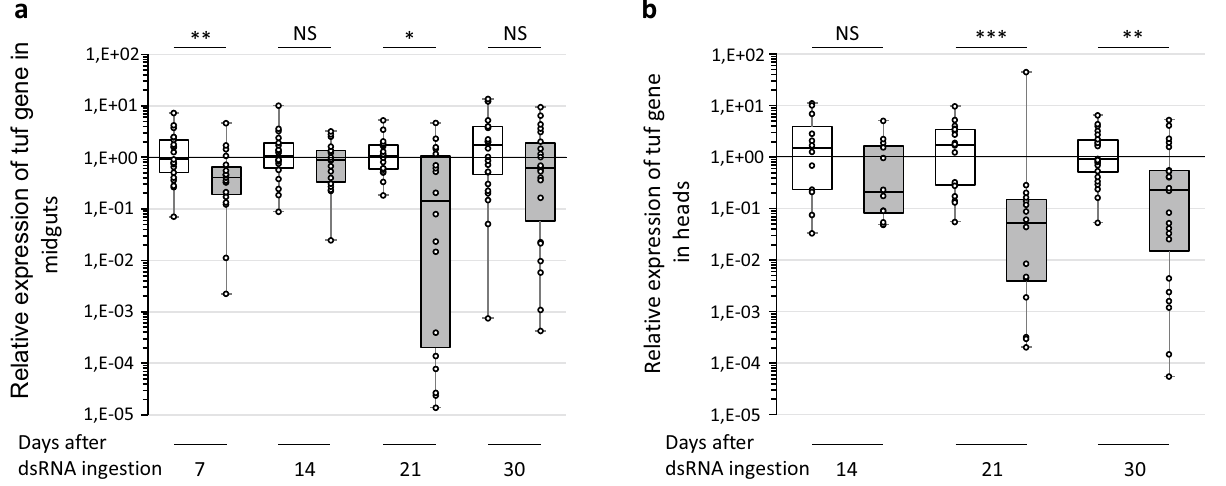
Figure 7. Expression of the phytoplasma elongator factor Tu (tuf) gene in the midguts ( a ) and in the salivary glands ( b ) regards to the reference genes glutathione S-transferase and tubulin β. White boxes correspond to E. variegatus that ingested GFP dsRNA and acquired phytoplasmas on infected broad beans for 7 days. Grey boxes correspond to E. variegatus that ingested chc dsRNA and acquired phytoplasmas on infected broad beans for seven days. The insects were then placed onto non-infected broad beans. *Indicates a significant difference with p < 0.05, **with p < 0.01, ***with p < 0.001 and NS indicates no significant difference under the Kruskal–Wallis rank sum test of the R commander package of R software version